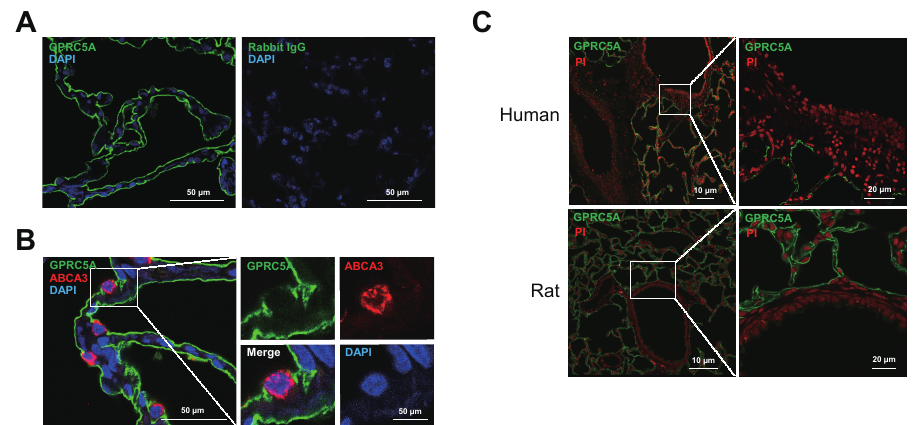
Figure 6. GPRC5A expression in human and rat lung. ( A ) Representative single staining for GPRC5A (green) in human distal lung. Blue = DAPI. Rabbit IgG (right panel) is the negative control. ( B ) Representative double staining for GPRC5A (green) and ABCA3 (red) in human distal lung. Blue = DAPI. Negative controls are showed in Supplemental Figure S7C. ( C ) Representative single staining for GPRC5A (green) in human (upper panel) and rat (lower panel) airway. White box indicates airway. Red = propidium iodide (PI).